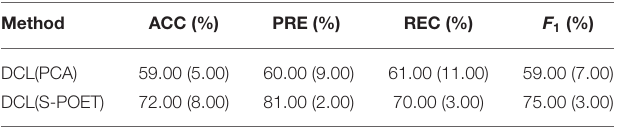
TABLE 3 | Influence of shrinkage principal orthogonal complement thresholding method (S-POET) on XGBoost with CNP dataset.